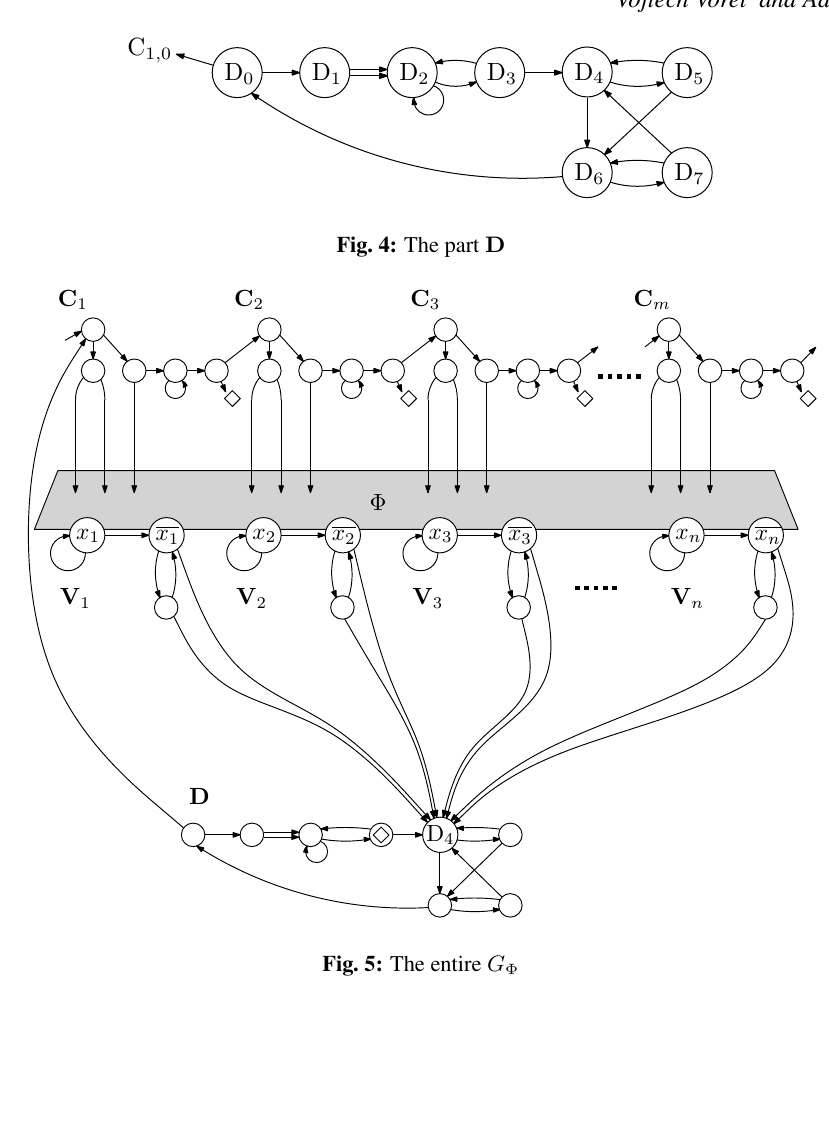
Φ is satisfiable (cid:109) has a reset word of length 4 Φ